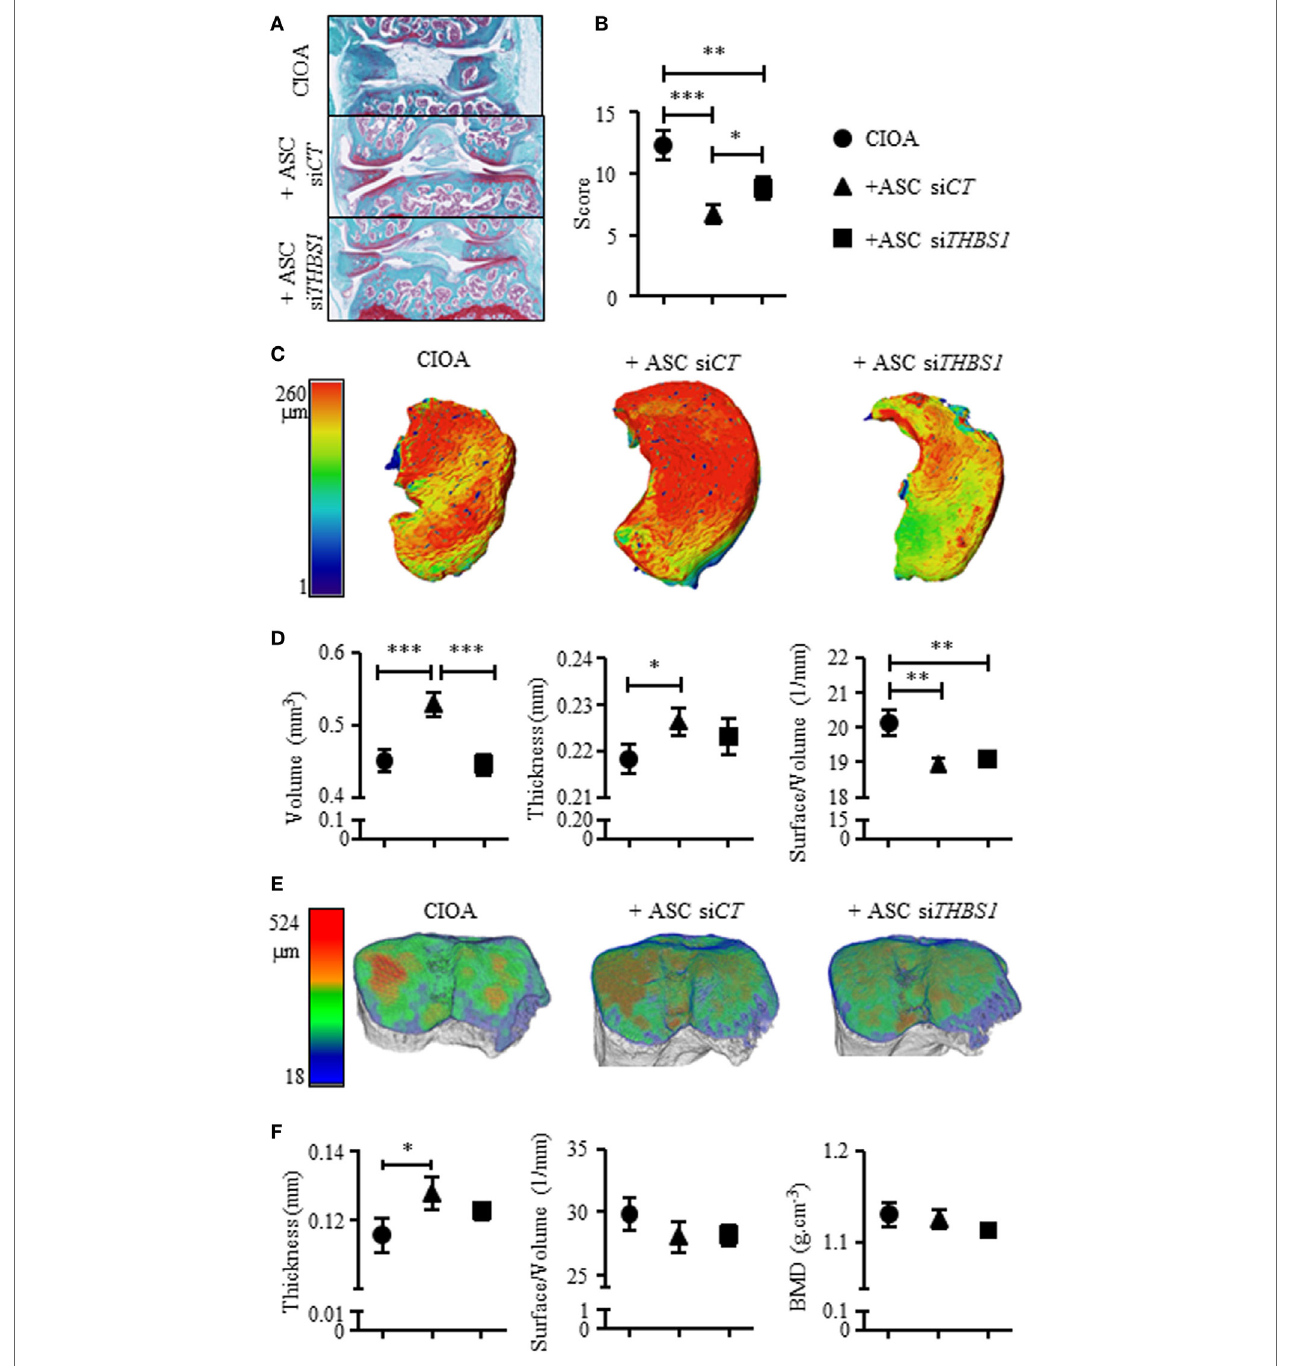
FigUre 5 | Effect of the downregulation of thrombospondin-1 (THBS1) in adipose stem cells (ASCs) in the collagenase-induced osteoarthritis (CIOA) murine model. (a) Representative photographs of knee joints from control CIOA mice (collagenase alone) (upper), and CIOA mice treated with ASC-si CT (middle) or ASC-si THBS1 (lower) and (b) OA score for cartilage destruction as evaluated on histological sections of knee joints ( n = 20/group). (c) Representative reconstructed 3D pictures of knee joint cartilage after confocal laser scanning microscopy analysis. A color bar code indicative of cartilage thickness was added on the left. (D) Cartilage morphometric parameters [cartilage volume, thickness, and surface irregularity (surface/volume)] were measured for the three groups of mice. (e) Representative reconstructed 3D pictures of tibiae epiphyses after microtomography analysis. A color bar code indicative of thickness was added on the left. (F) Bone morphometric analysis of sub-chondral bone measuring surface irregularity (surface/volume; 1/mm), thickness (mm), and bone mineral density (BMD; g/cm 3 ) was performed. Results are expressed as mean ± SEM ( n = 20/group). Statistics used ANOVA test: * p < 0.05, ** p < 0.01, *** p < 0.001 compared to CIOA control